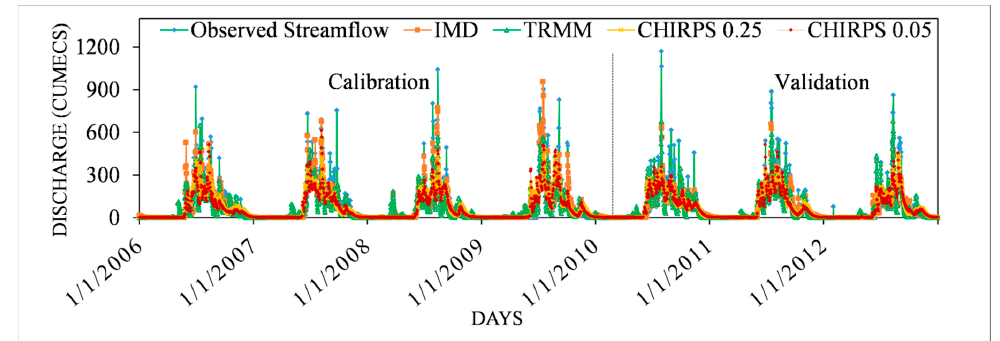
Figure 4. Daily simulation of streamflow for di ff erent precipitation